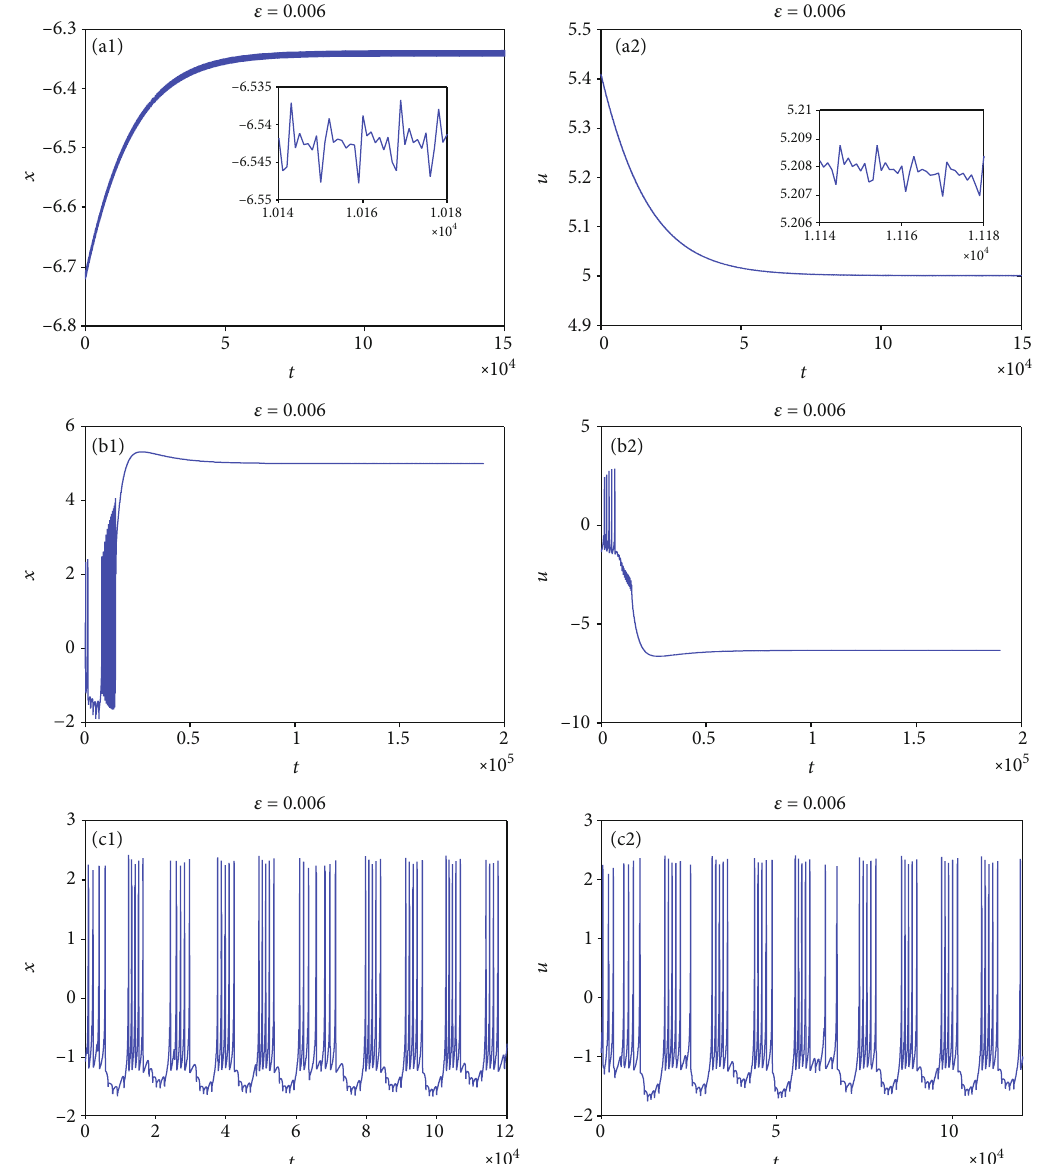
Figure 17: Multiple fi ring patterns of model (8) with small-scale ε changing when k = 0 : 1 and I